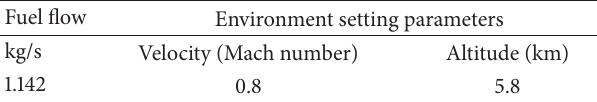
Table 3: Description of the studied operating